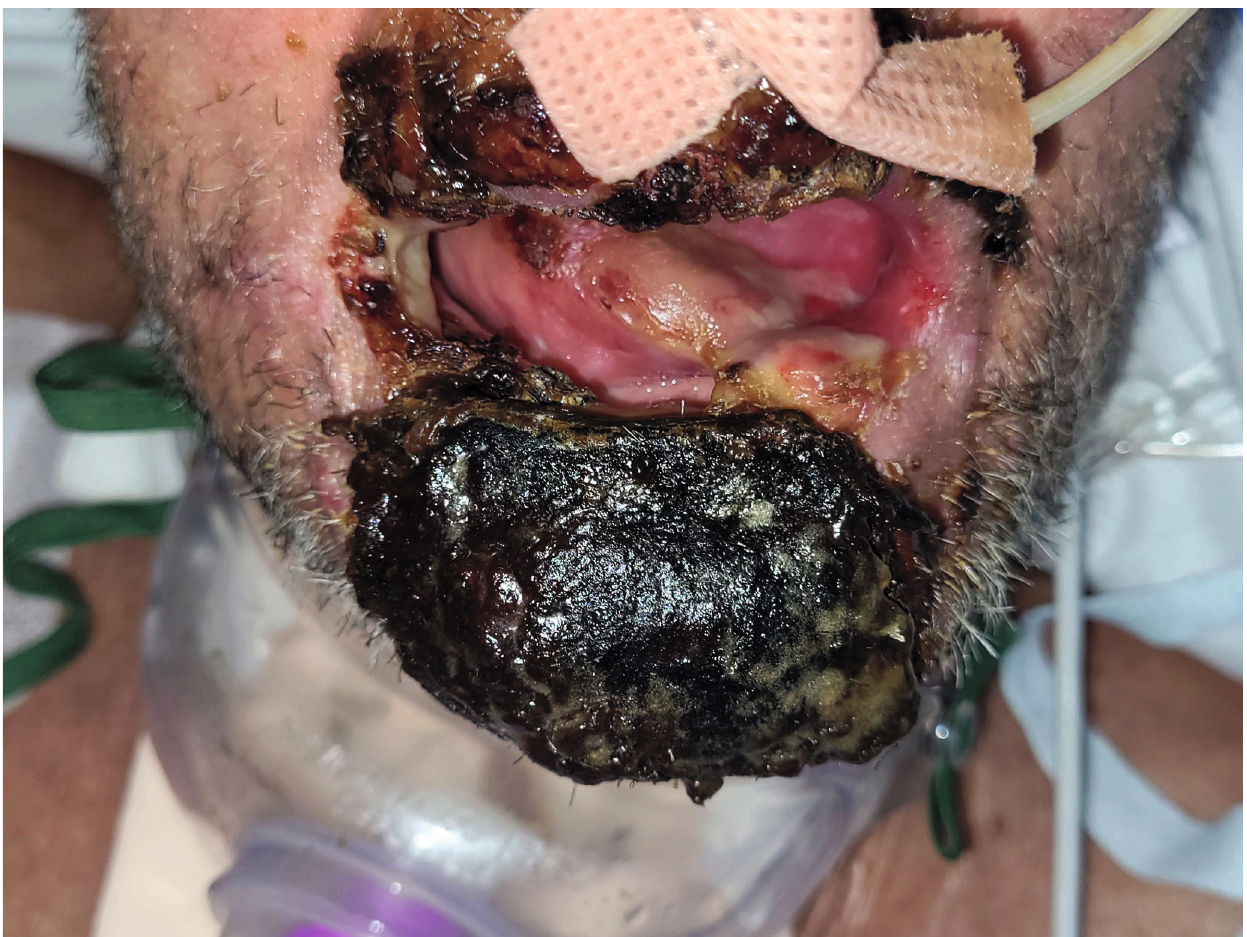
Figure 1: Tongue tethered to lower left lip due to granulation and associated extensive